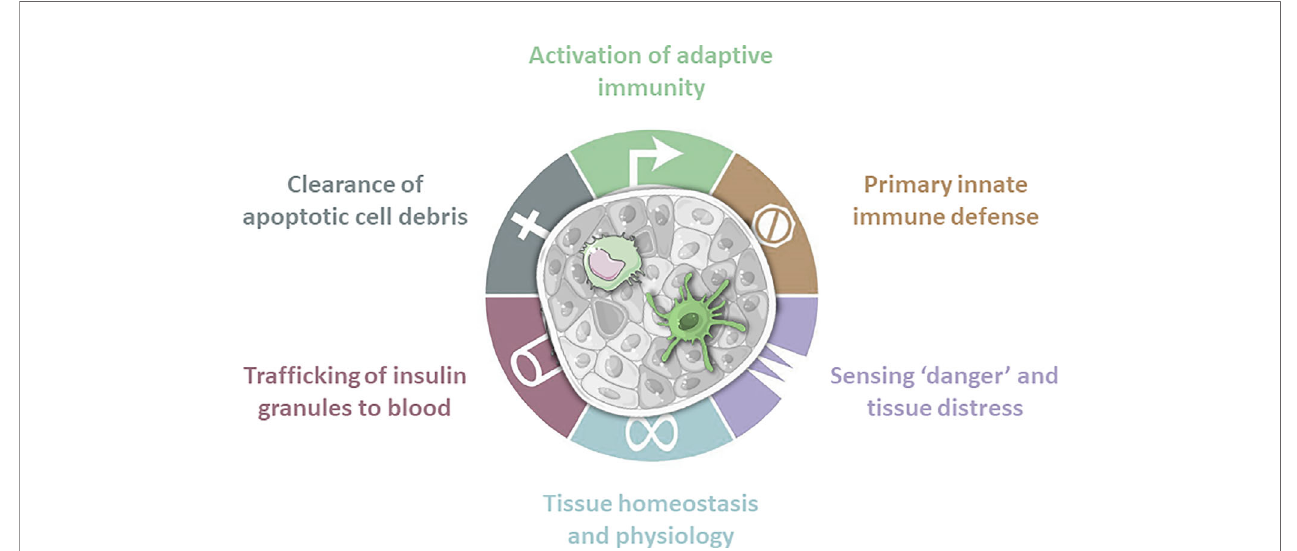
FIGURE 1 | Antigen presenting cells are present in islets of Langerhans. These innate immune cells ful fi ll a wide range of tasks. Macrophages play a crucial role in tissue homeostasis and physiology by expressing tissue remodeling cytokines. Due to constant sampling of the surrounding environment they clear apoptotic cell debris, but also sense danger signals and tissue distress. Obtained granules are then traf fi cked to the blood. In case of invading pathogens macrophages and dendritic cells are fi rst line of defense. Dendritic cells are mainly involved in screening for danger signals and subsequent activation or regulation of the adaptive immune